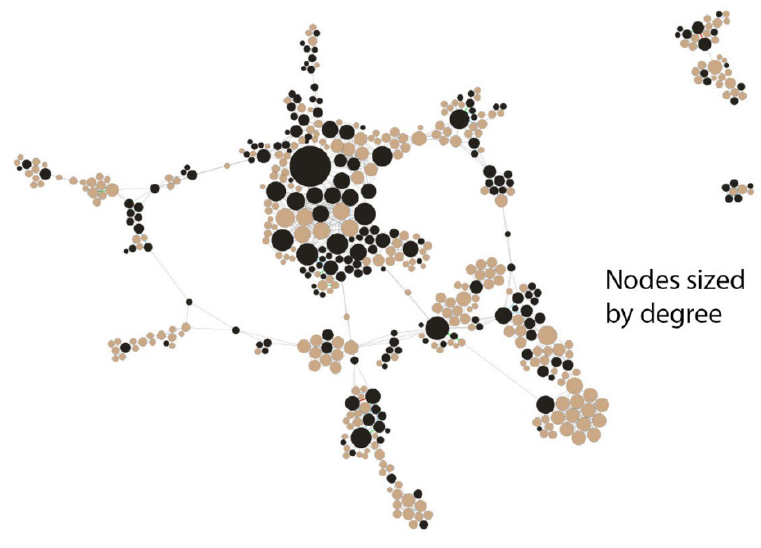
Nodes sized by degree (number of collaborative author relationships) and color-coded by MLA member status, with black indicating MLA members and tan indicating non-MLA